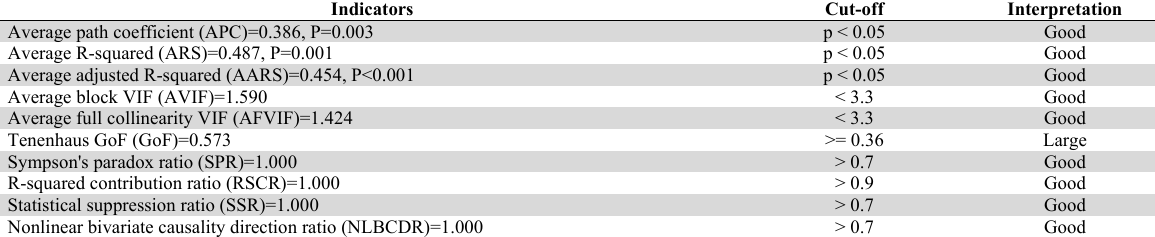
Model Fit Test Value